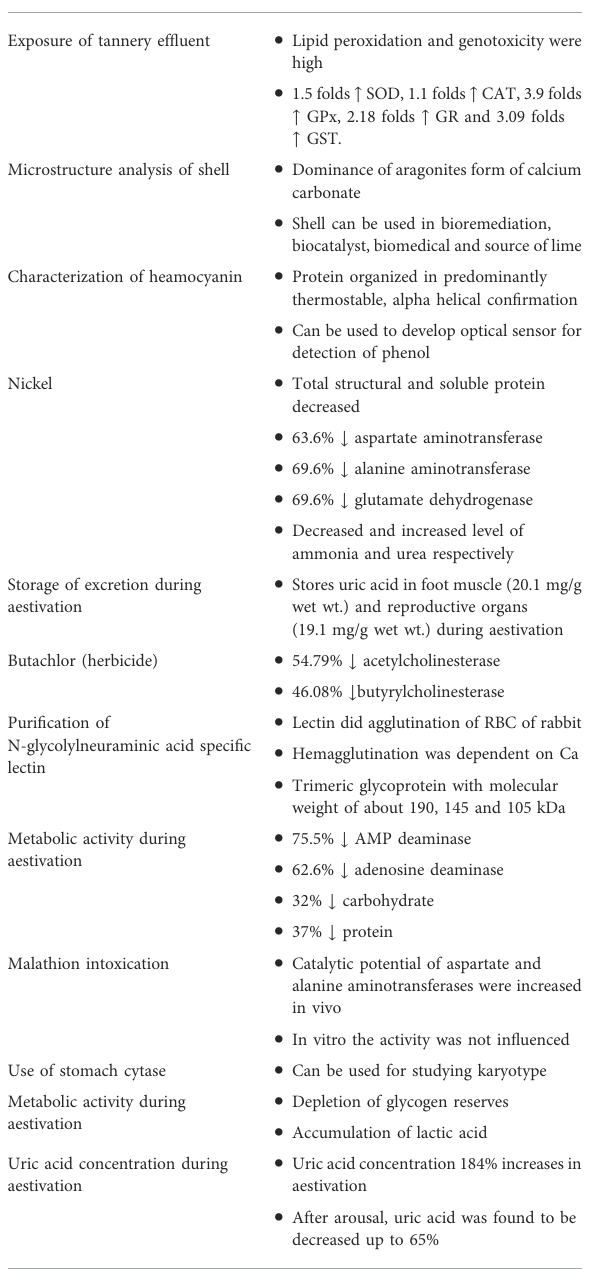
TABLE 3 Effect of different toxic modulators on physiology of P. globosa